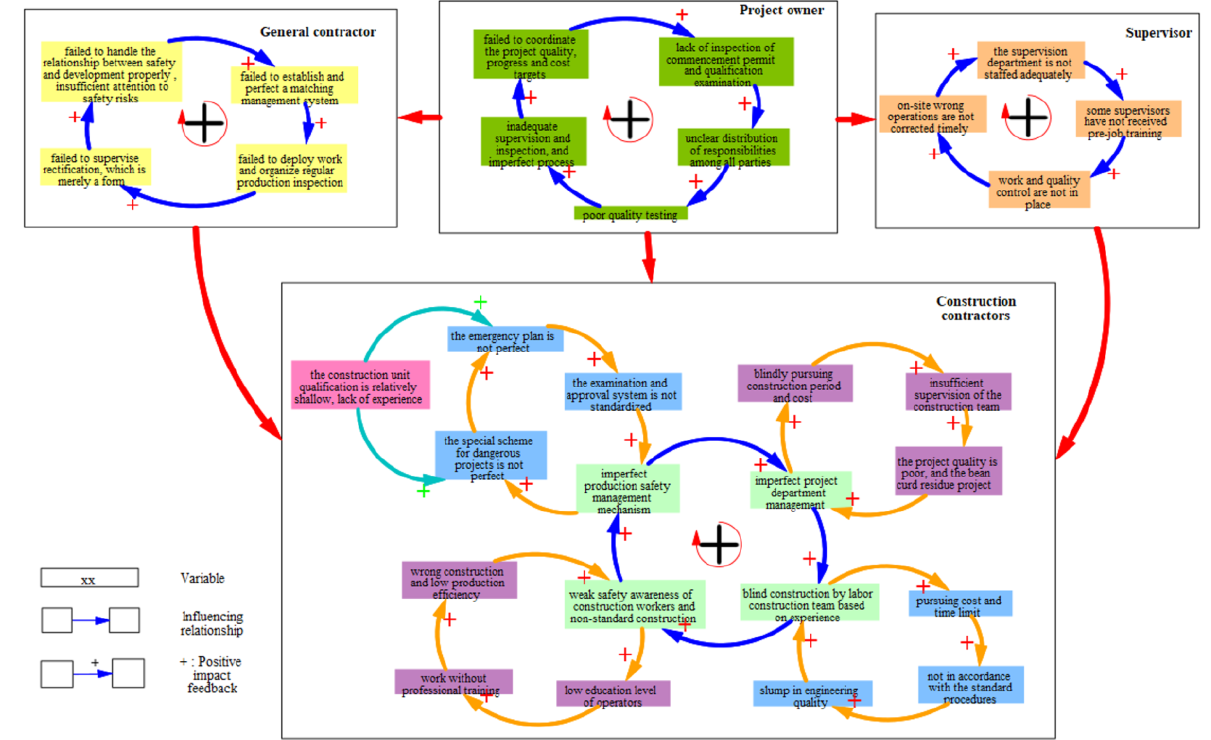
Figure 6. Causal loop diagram of participant management factors.